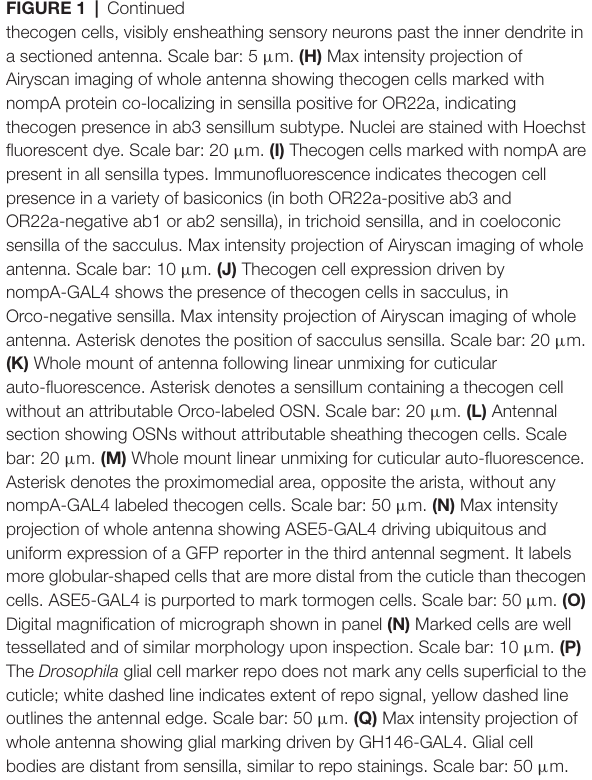
a sectioned antenna. Scale bar: 5 µ m. (H) Max intensity projection of Airyscan imaging of whole antenna showing thecogen cells marked